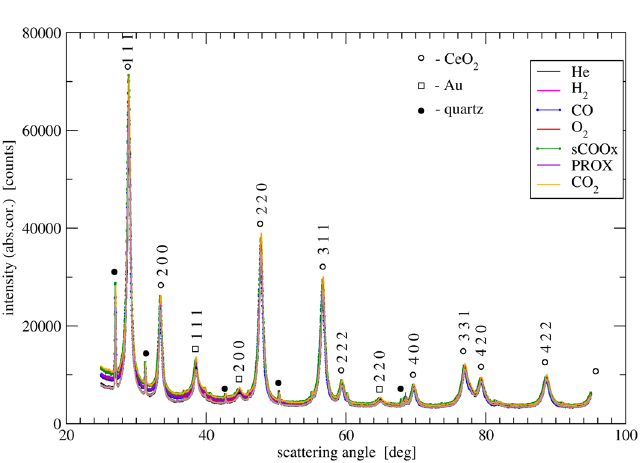
Figure 4. DPs of the Au/CeO 2 catalyst exposed to a sequence of